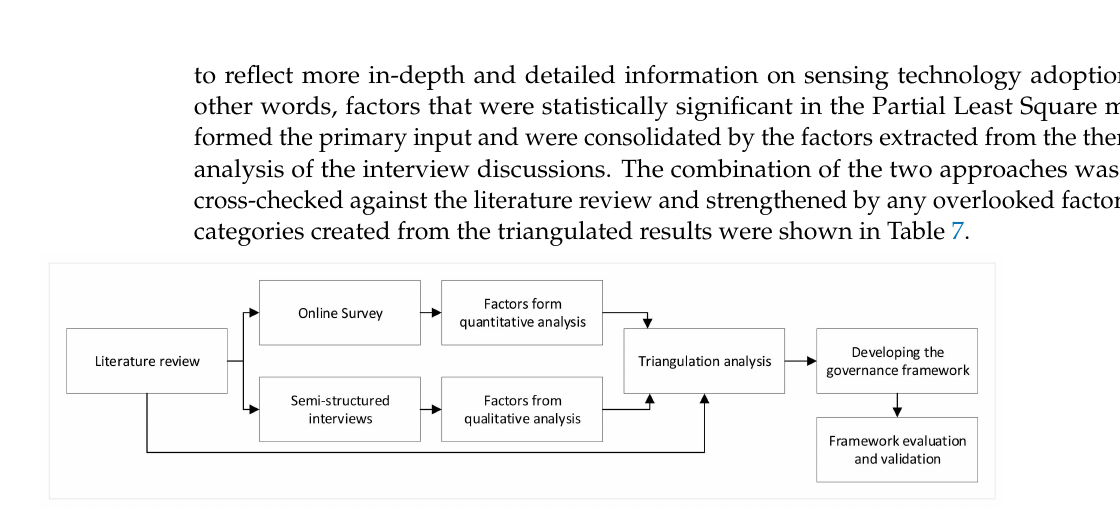
Figure 11. Triangulation method for the governance framework development. Table 7. Categories for triangulated